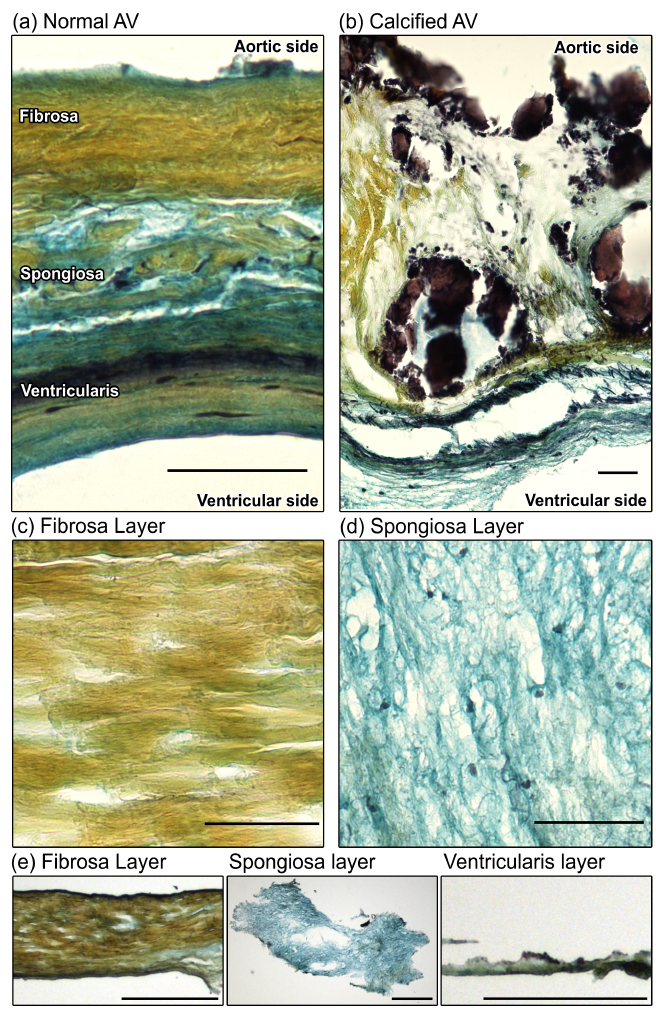
Figure 1. Movat’s pentachrome staining of structural organization in a circumferential cross-section of a human AV leaflet. Yellow = collagen, blue = glycosaminoglycans (GAGs), black = elastin, dark brown/black = calcification: ( a ) Tri-layered arrangement of the fibrosa (collagen-rich), spongiosa (GAG-rich), and ventricularis (elastin-rich) layers in a healthy leaflet; ( b ) Disruption of the leaflet layers by calcifications (black) and fibrosis (yellow regions) in CAVD; ( c , d ) Staining of collagen in the dissected fibrosa layer and GAGs in the dissected spongiosa layer confirmed distinct layer separation; scale bar = 50 µ m; ( e ) Low-magnification images of microdissected fibrosa, spongiosa, and ventricularis layers; scale bar = 500 µ